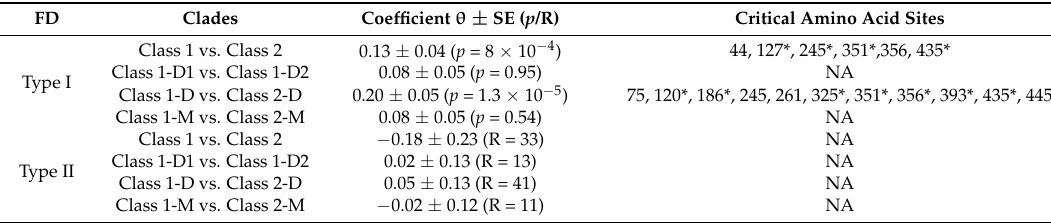
Table 1. Analysis of functional